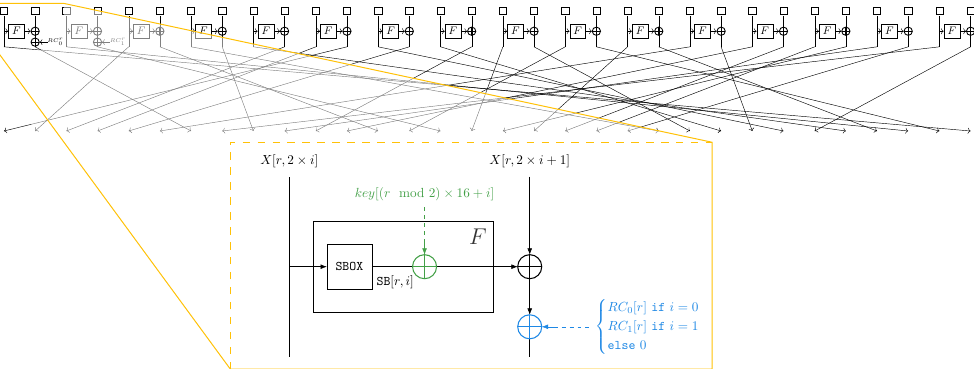
Figure 1: One round of WARP . The constant addition in blue ( — ) plays no role when searching for differential properties, and the round key addition in green ( — ) can be ignored when considering the single key